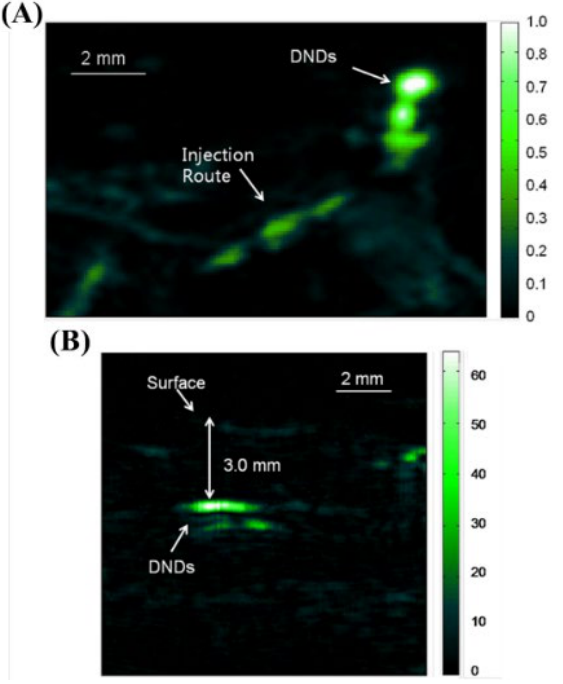
Figure 14. Photoacoustic images taken after injecting DNDs subcutaneously at ( A ) the back (MAP image) and ( B ) the ventral side of the thigh of the mouse (B-scan image). Reprinted from Zhang et al., J. Biomed. Opt., 2013, 18, 2: 026018 [28], with permission from the Optical Society of America.